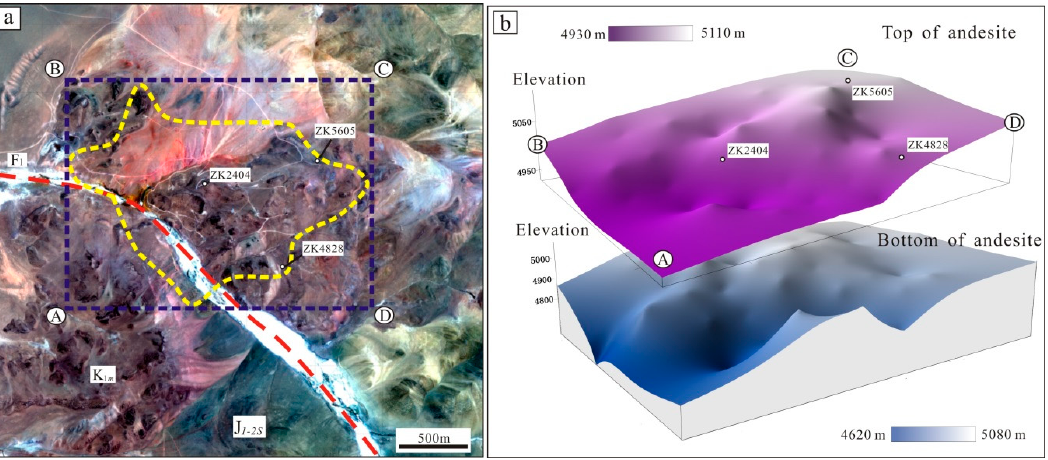
Figure 7. ( a ) High-resolution remote sensing image, and ( b ) a 3-D map of the Meiriqiecuo Formation andesite [31]. Red dotted lines: faults; the yellow dotted line: the boundary of the mineralized body.